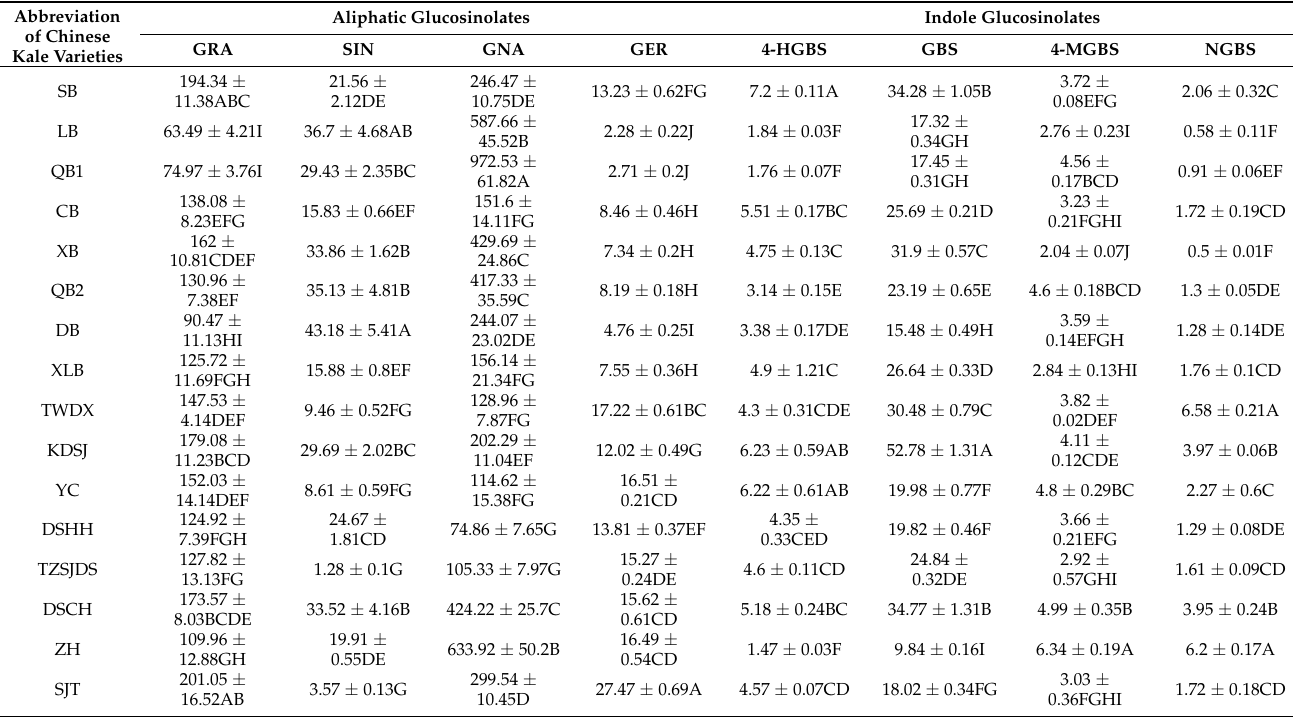
Table 5. Composition and accumulation of glucosinolates ( µ mol/100 g DW) in the edible stems of 16 varieties of Chi- nese